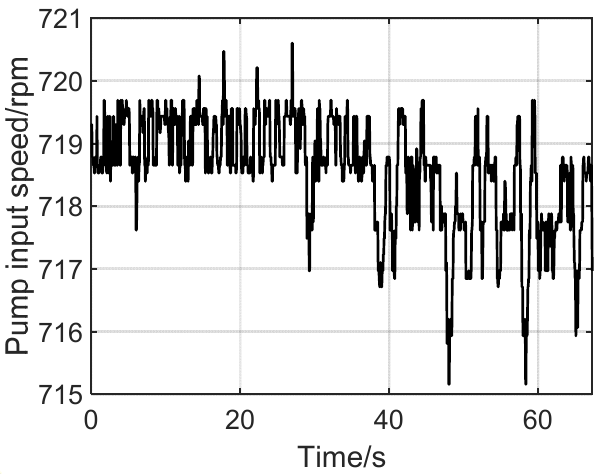
Figure 7. Measured input speed of variable pump.